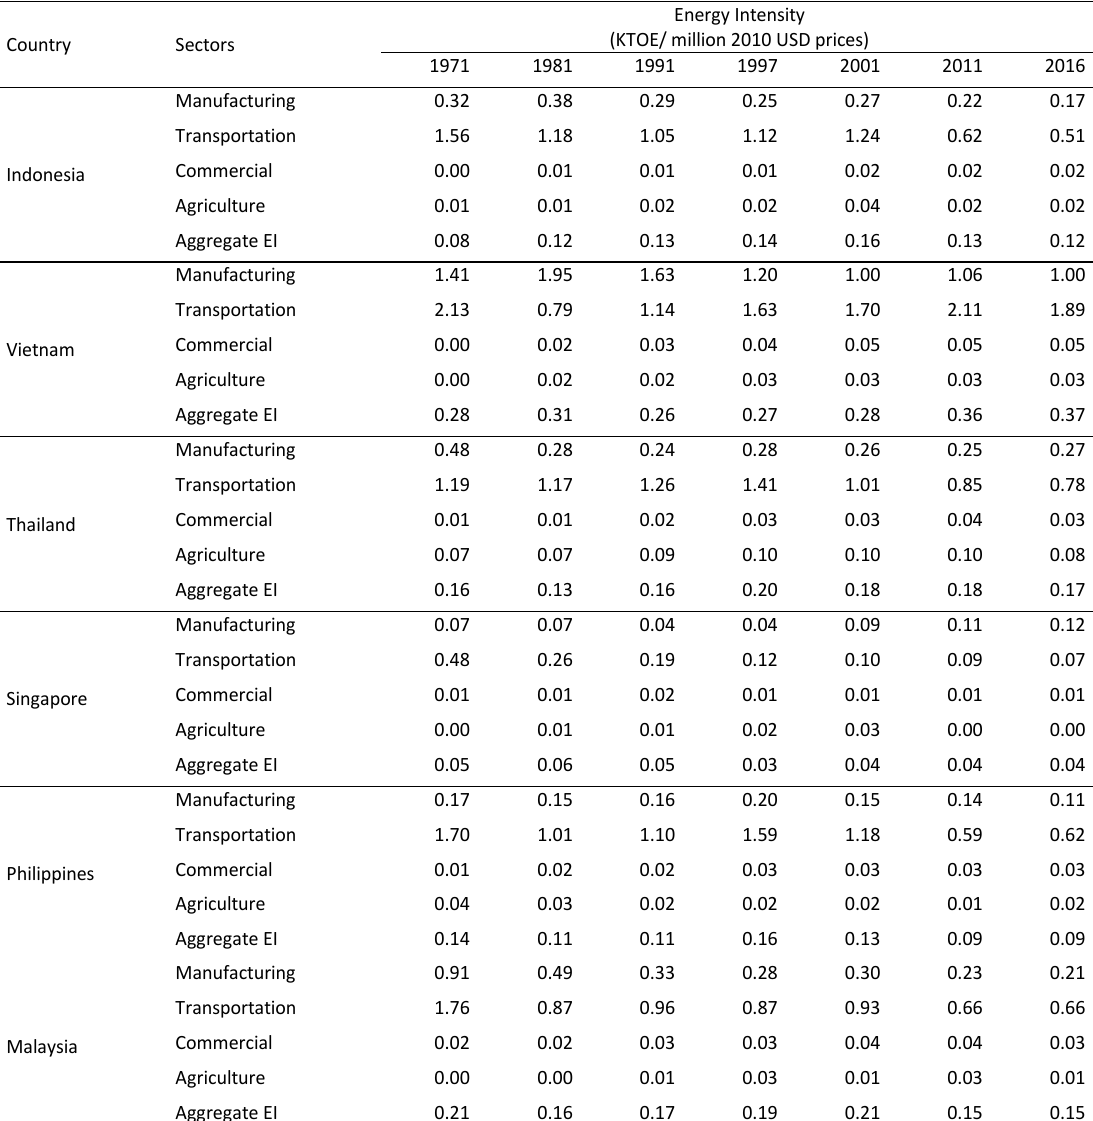
Table 3: Energy intensity trend ASEAN-6